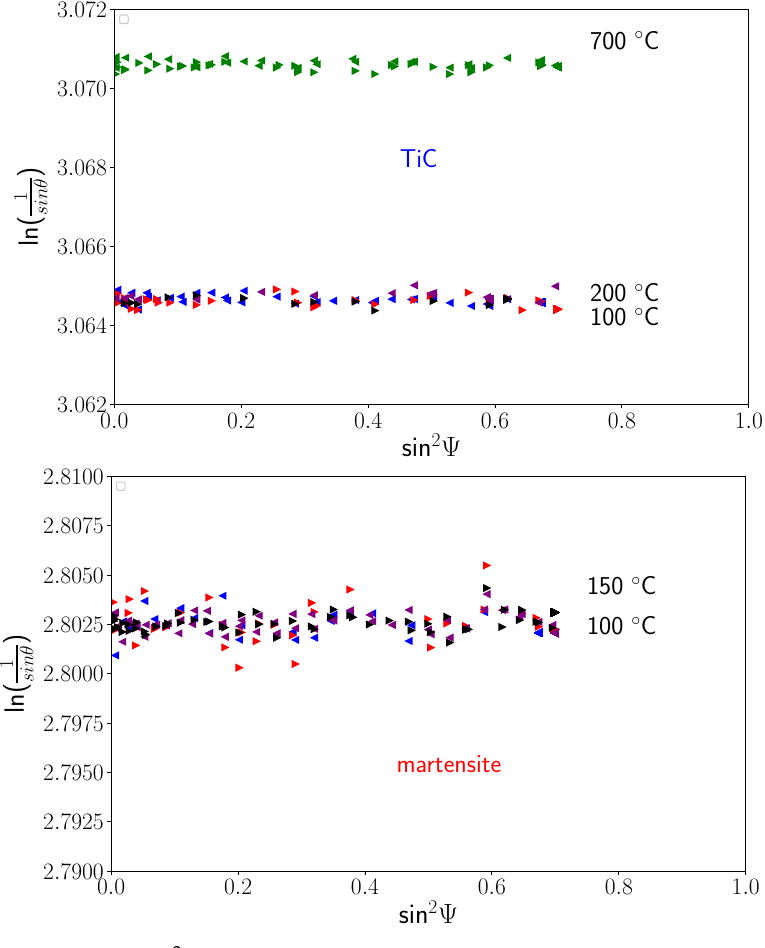
Figure 10. Evolution of the sin 2 Ψ curves at different temperatures for steel- γ phase, TiC, and steel- α (cid:48) phase.